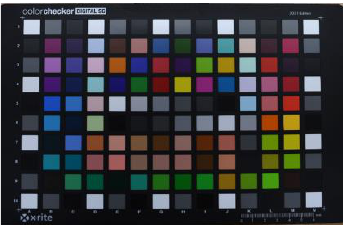
Figure 3. ColorChecker DigitalSG for colour calibration.